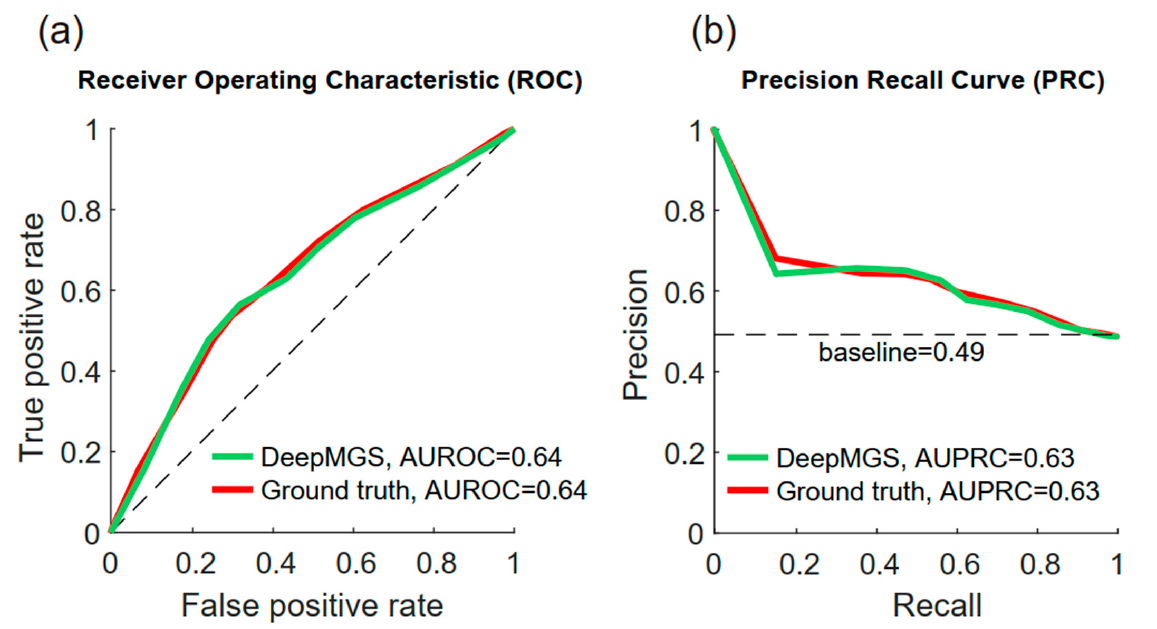
Figure 4. Comparison of the performance of DeepMGS and the ground truth in distinguishing NTG and saline conditions by the receiver operating characteristic (ROC) and precision-recall (PRC) curve analyses. ( a ) The ROC curves of the DeepMGS (green line) and ground truth (red line). The area under the ROCs of the DeepMGS and ground truth were 0.64 and 0.64, respectively, indicating that the performance of the DeepMGS in distinguishing NTG and saline conditions is comparable to that of an experienced scorer. ( b ) The PRC curves of DeepMGS (green line) and ground truth (red line). The area under the PRCs of the DeepMGS and ground truth were 0.63 and 0.63, both higher than the baseline (0.49), suggesting the performance of the DeepMGS is favorable even for the imbalanced datasets. Table 4. Comparison of the performance of DeepMGS and three apprentice human scorers in dis- tinguishing NTG and saline conditions with ground truth by linear regression analyses.